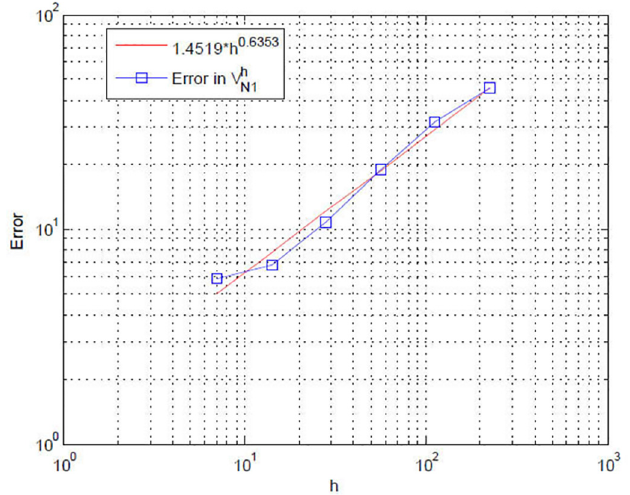
Fig 1. Computed errors in the L 1 -norm at t =